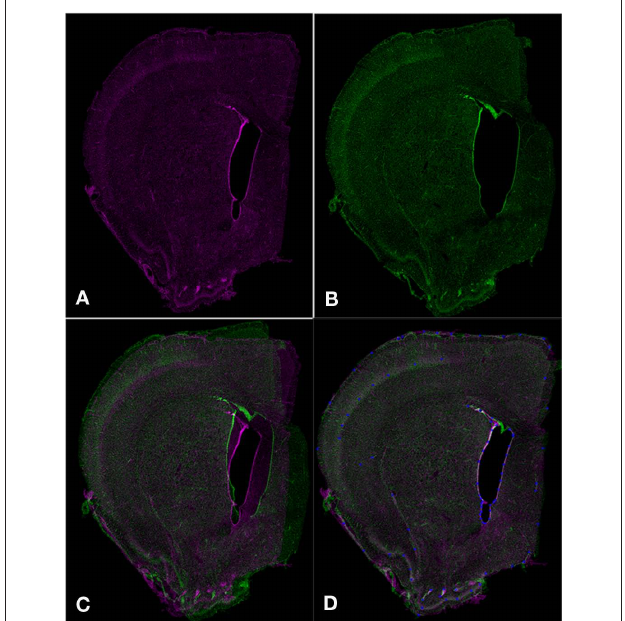
Figure 6 | Aligning serial sections using ir-Tweak. Image (A) shows a wide-field view of overlaid adjacent slices in the application ir-Tweak (reference points shown as white open circles) before applying any transformation. Image (B) shows a high-magnification image of the hippocampus from (A) . This image demonstrates the mis-alignment of serial sections before applying the thin plate spline transformation in ir-Tweak. Image (C) shows the same high-magnification image from (B) after applying the thin plate spline transformation in